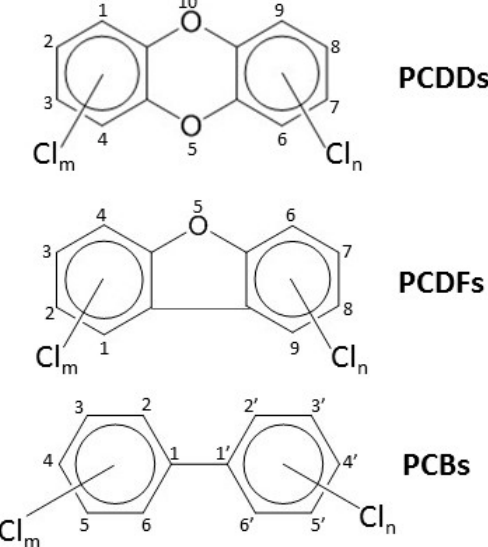
Figure2. Structuralformulasofdioxins. Thereare75, 135, and209possiblecongenersofpolychlorinated Figure 2. Structural formulas of dioxins. There are 75, 135, and 209 possible congeners of 111 dibenzo- p -dioxins (PCDDs), polychlorinated dibenzofurans (PCDFs) and polychlorinated biphenyls polychlorinated dibenzo- p -dioxins (PCDDs), polychlorinated dibenzofurans (PCDFs) and 112 polychlorinated biphenyls (PCBs), respectively. For toxic PCDD/Fs (17 congeners), at least the lateral 113 (PCBs), respectively. For toxic PCDD / Fs (17 congeners), at least the lateral ( para -) positions (2, 3, 7, 8) have chlorine substituents. For dioxin-like polychlorinated biphenyls (DL-PCBs) (12 congeners), there is maximally one chlorine atom in the ortho -positions (2, 2 (cid:48) , 6, 6 (cid:48) ) and at least 4 chlorine atoms in the meta -(3, 5, 3 (cid:48) , 5 (cid:48) ) and para- (4, 4 (cid:48) )